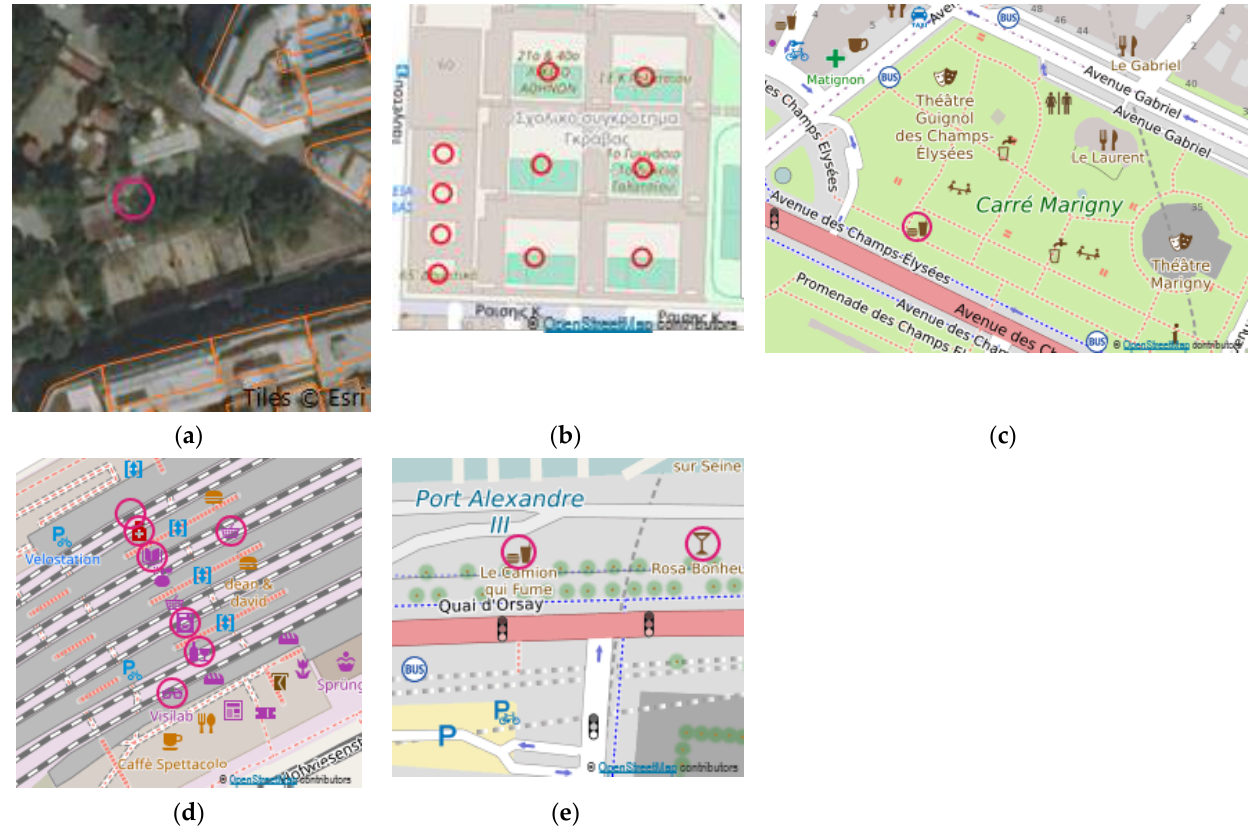
Figure 7. Errors for POIs in Check 1 resulting from ( a ) building omission (Athens), ( b ) POIs misplaced in the buildings (e.g., in the patio (Athens)), ( c ) false errors resulting from exceptions to the rules (e.g., restaurants or kiosks in parks (Paris)), ( d ) shops in railway stations (Zurich), and ( e ) bars in the riverfront (Paris). Table 7. Statistics for POI distances from railways (Check